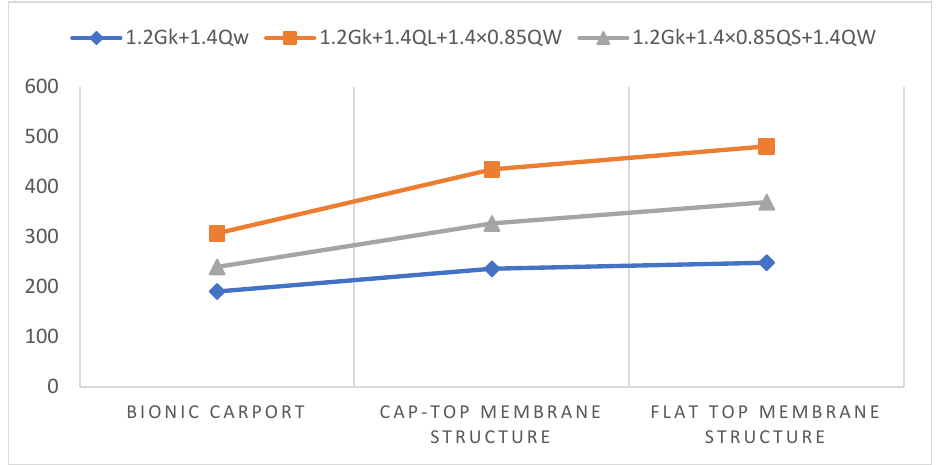
Figure 32. Folding line diagram of nonlinear displacement of different types of carports under ultimate load. The data in the figure are from the simulation results of finite element software.